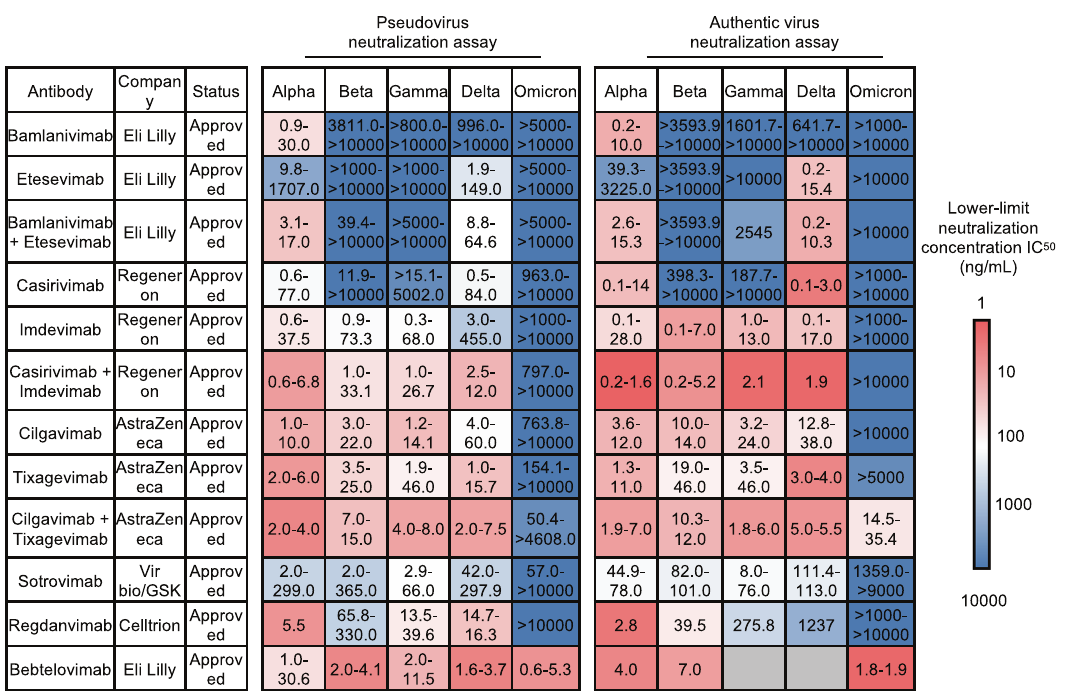
Fig. 6 The summary of neutralization capability of approved antibodies against in vitro pseudovirus and authentic virus infection from SARS- CoV-2 variants. The ranges of reported neutralization capability against each VOC are listed. The lower-limit concentration IC 50 are indicated in a red-to-blue color scale to represent the minimal neutralizing capability of each antibody reported. A bluer color indicates a reported stronger evasion of VOCs from antibody neutralization than ancestral strain. The detailed antibody neutralization concentration from each study could be referred in Supplementary Table